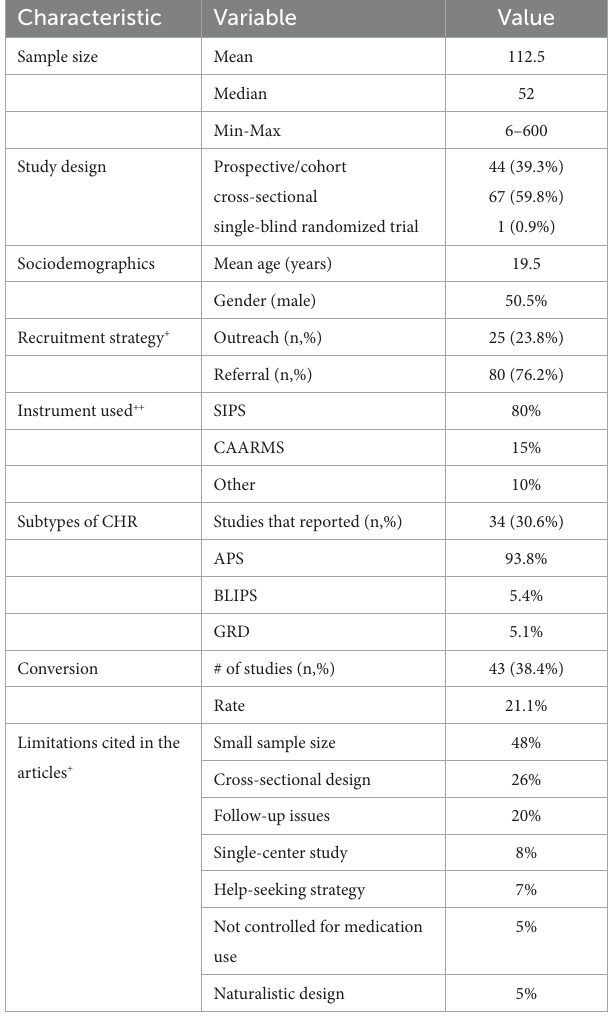
TABLE 2 Characteristics of included